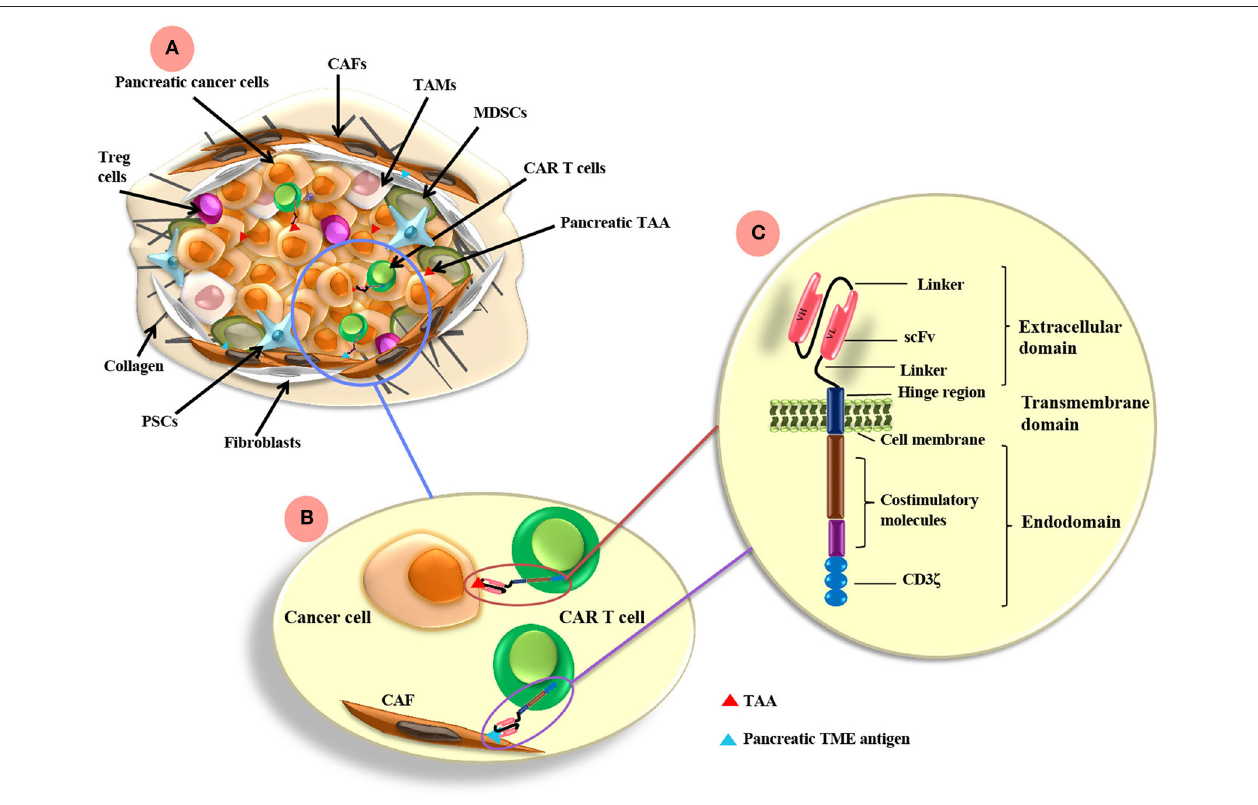
FIGURE 1 | CAR T cell antigen-targeting strategies and pancreatic cancer TME. (A) The pancreatic TME consists of tumor cells as well as many immunosuppressive cells, such as CAFs, TAMs, MDSCs, PSCs, and Treg cells. (B) CAR T cells can be directed to the TAA expressed on pancreatic cancer cells and/or other antigens targeting the TME components, such as FAP on CAFs. (C) CARs are composed of extracellular, transmemebrane and endo-domains. The extracellular domain consists of an antibody variable heavy chain (VH) and a light chain (VL) domain, which are derived from an scFv from an antibody specific for a TAA. A flexible hinge region links the extracellular domain to a transmembrane and endodomain. The endodomain has cytoplasmic signaling regions derived from CD3 ζ and costimulatory signaling domains. TAMs, tumor-associated macrophages; CAFs, cancer associated fibroblasts; MDSCs, myeloid-derived suppressor cells; Tregs, regulatory T cells; PSCs, pancreatic stellate cells; FAP, fibroblast activation protein; scFv, single chain variable fragment. TAA, tumor associated antigen; TME, tumor